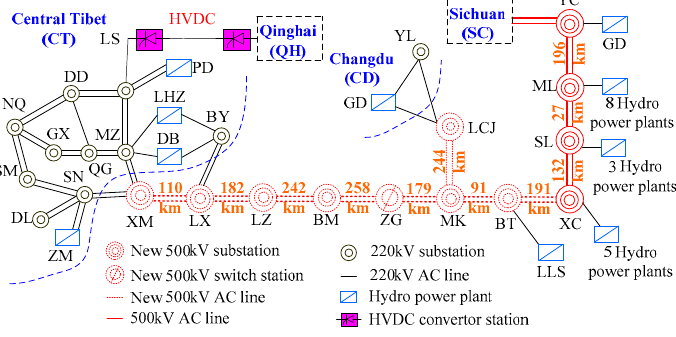
Figure 1. Structure diagram of central Tibet AC interconnection project (CTAIP).